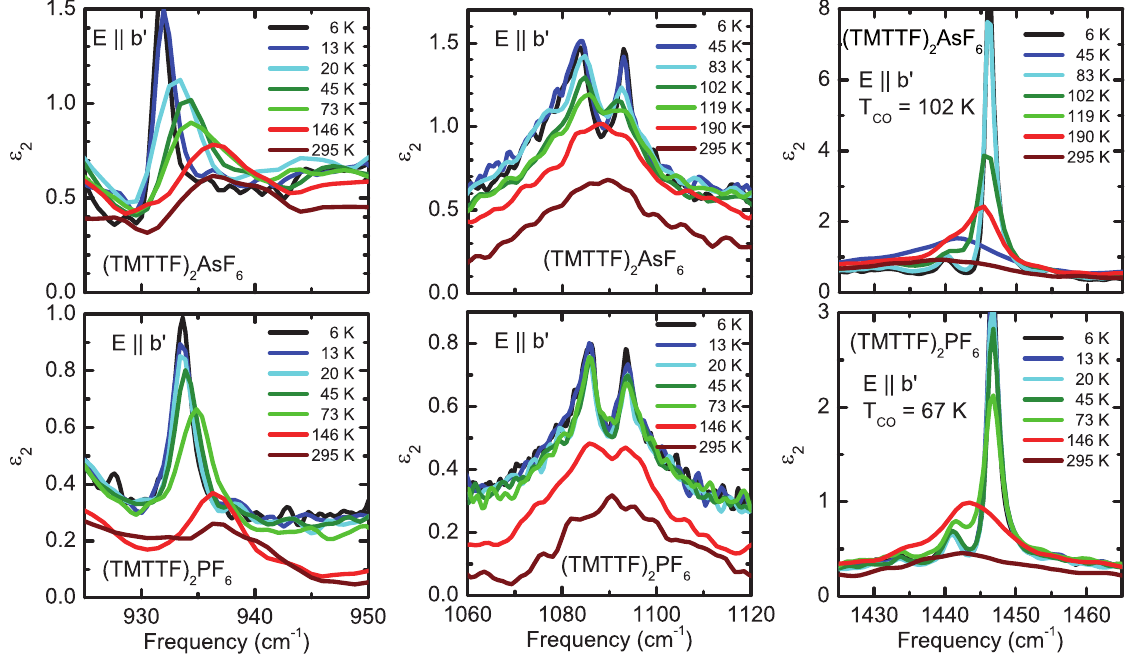
( ν ) of (TMTTF) Figure 13. Dielectric losses (cid:15) AsF and (TMTTF) PF for light polarized 2 2 6 2 6 perpendicular to the molecular stacks ( E (cid:107) b (cid:48) ) in the upper and lower frames, respectively. In the left panels the C − C − H bending vibration is observed around 935 cm − 1 . The ( b ) mode located around 1090 cm − 1 at room temperature splits as T antisymmetric ν 31 1 u = 102 and 67 K, respectively. The right panels show the temperature drops below T CO dependence of the H − C − H bending modes.